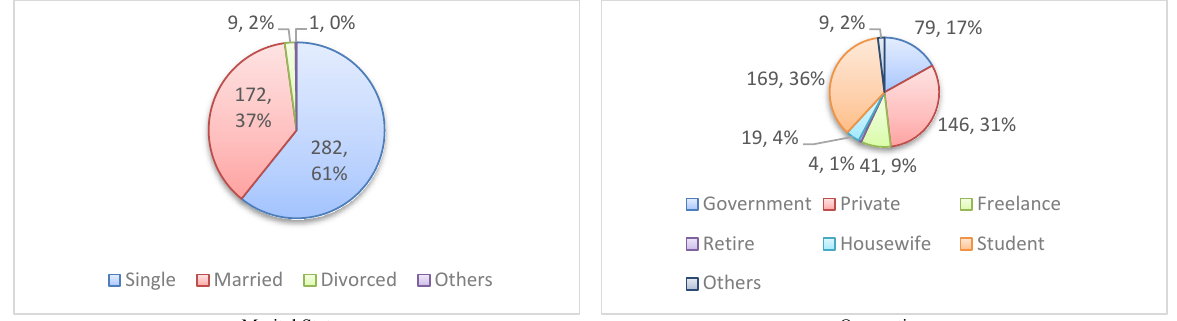
Fig. 2. Result of Demography Profile of Respondents